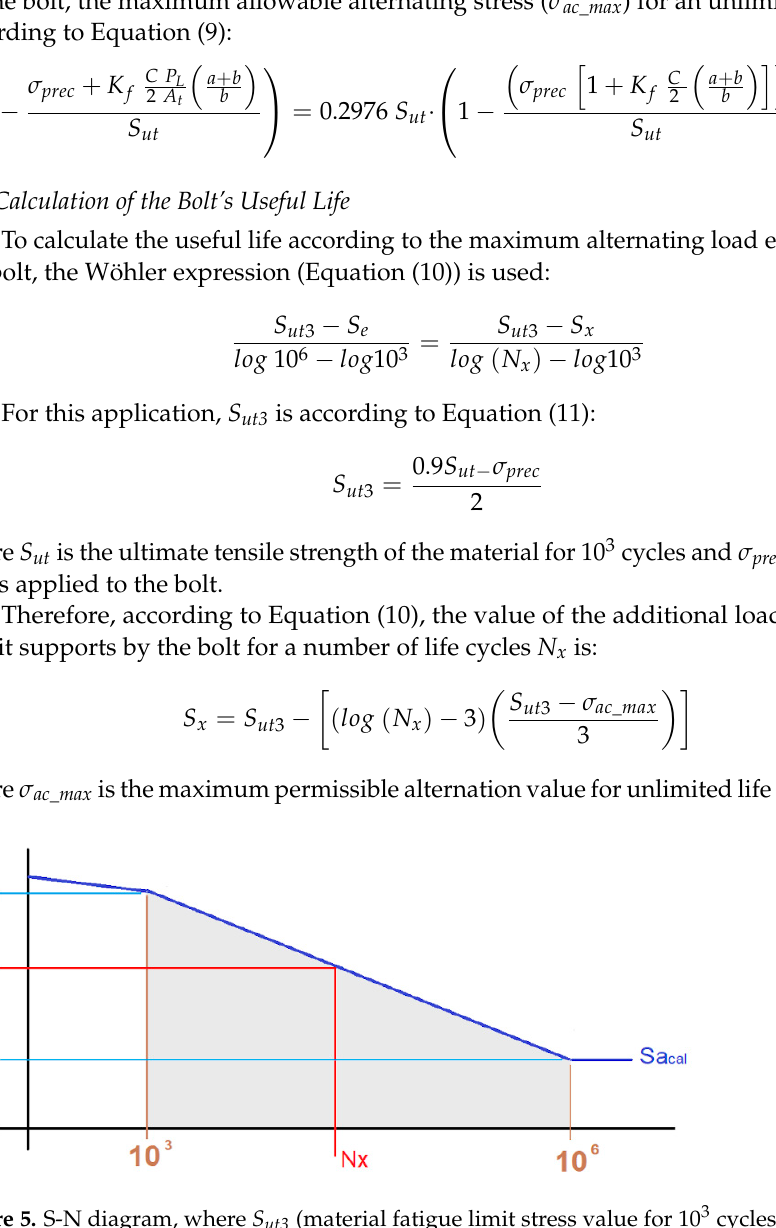
Figure 5. S-N diagram, where S ut3 (material fatigue limit stress value for 10 3 cycles) and S e are the calculated maximum alternating stress.